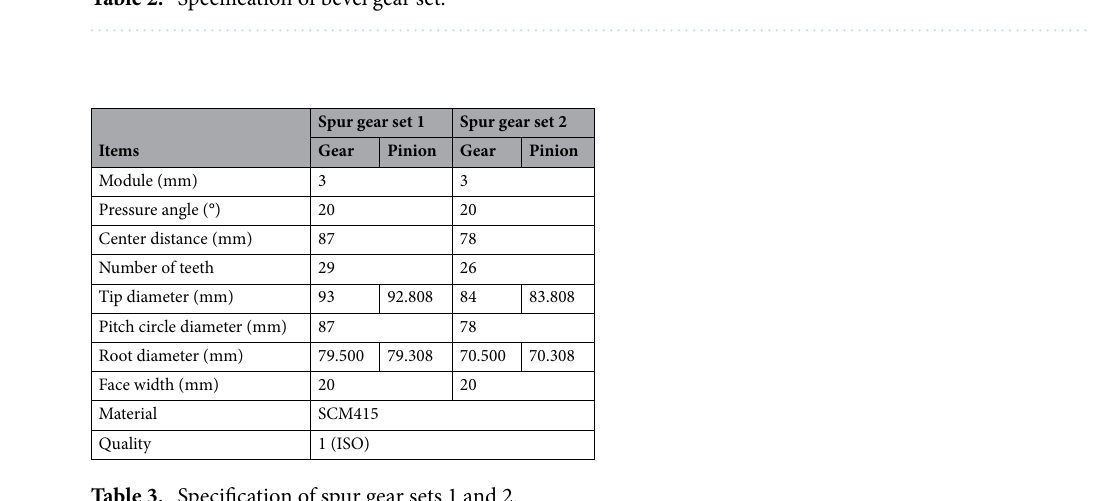
Table 2. Specification of bevel gear set.